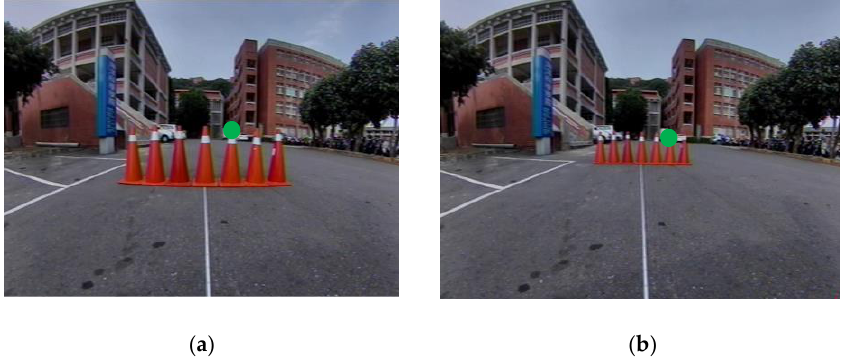
Figure 10. Diagram of same image coordinates correspond to different radar coordinates ( a ) Radar detection distance is 2.2 m and ( b ) Radar detection distance is 4 m.